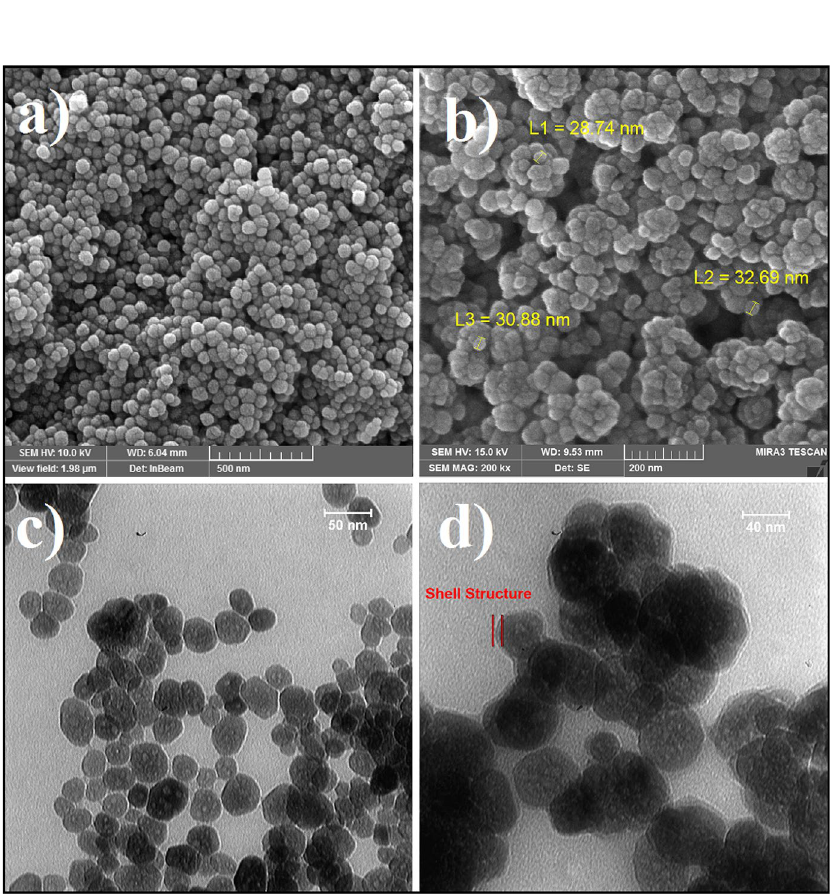
Figure 4. SEM ( a ) and TEM ( c ) images of Fe 3 O 4 and SEM ( b ) and TEM ( d ) images of Fe 3 O 4